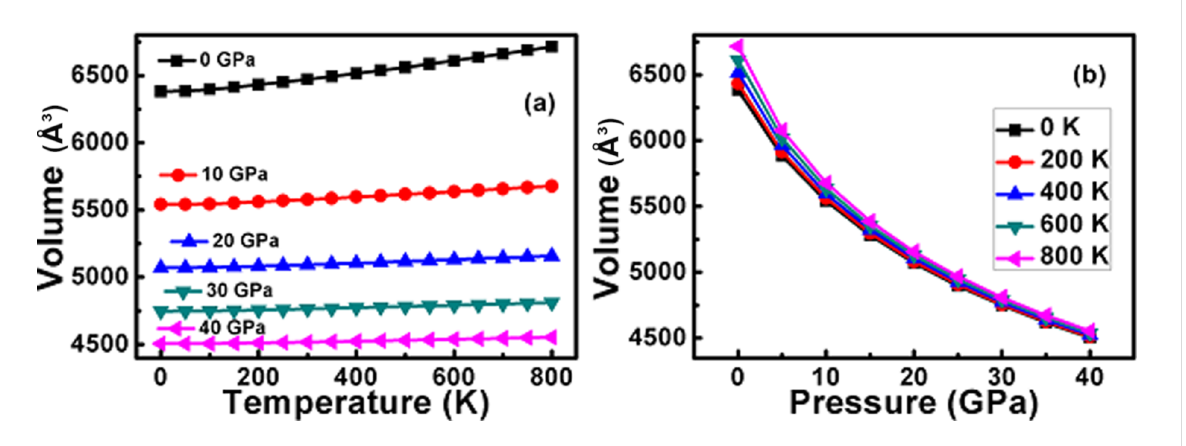
Figure 7: Variation of the primitive unit cell volume as a function of (a) temperature and (b) pressure for the π -SnSe alloy.